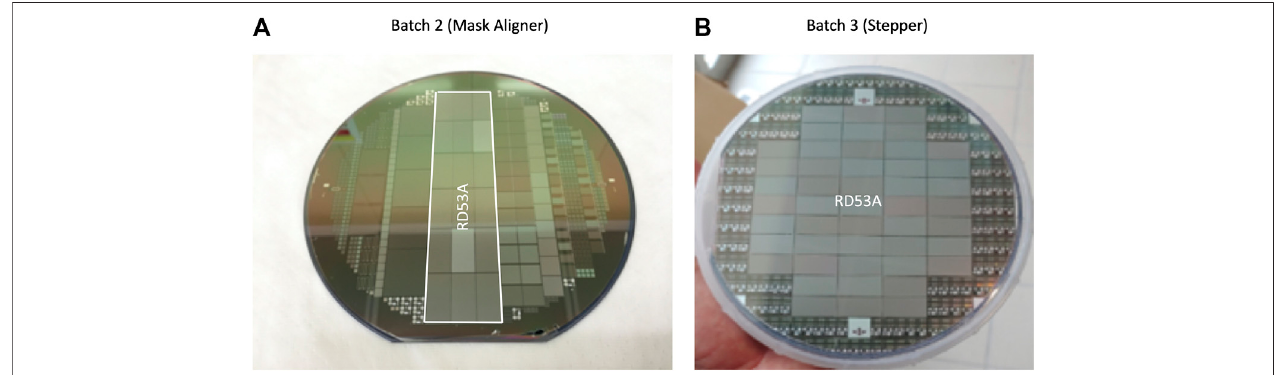
FIGURE5| Photographofprocessedwafersfrombatch2 (left) andbatch3 (right) :18RD53A-compabilesensorsarepresentinawaferfrombatch2,47ofthem in a wafer from batch 3.